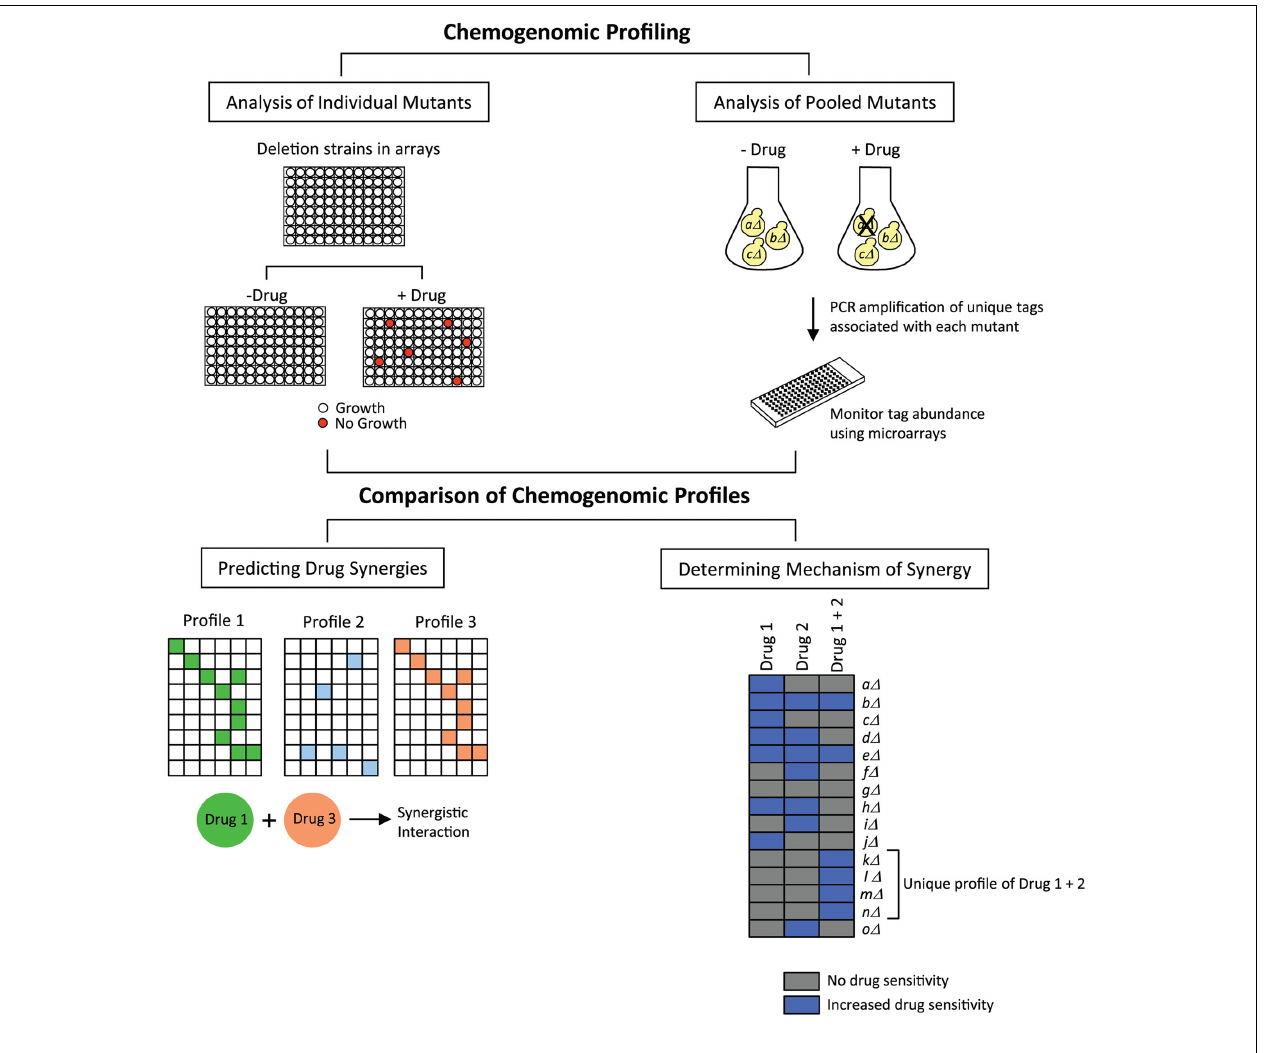
associated with each mutant, using DNA microarrays consisting of tag complements.Two drugs with similar chemogenomic profiles would be predicted to exhibit a synergistic interaction (for simplicity, exactly matching profiles are depicted). If the combination of two synergizing drugs generates a unique chemogenomic profile of sensitive mutants, then genes deleted in those mutants provide information on the drug synergy